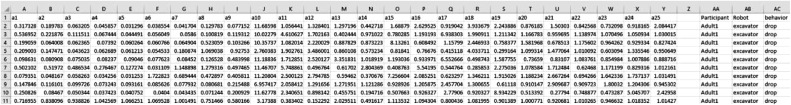
The arrangement of the data inside the dataset files. The first 25 columns (i.e., a1 till a25) represent the acceleration values. These values can be used as an input for a machine learning technique (e.g. neural network). The last three columns (i.e., AA, AB, and AC) indicate the participant number, the robotic toy used, and the behaviour. The behaviour column can be used as the output for the machine learning technique.